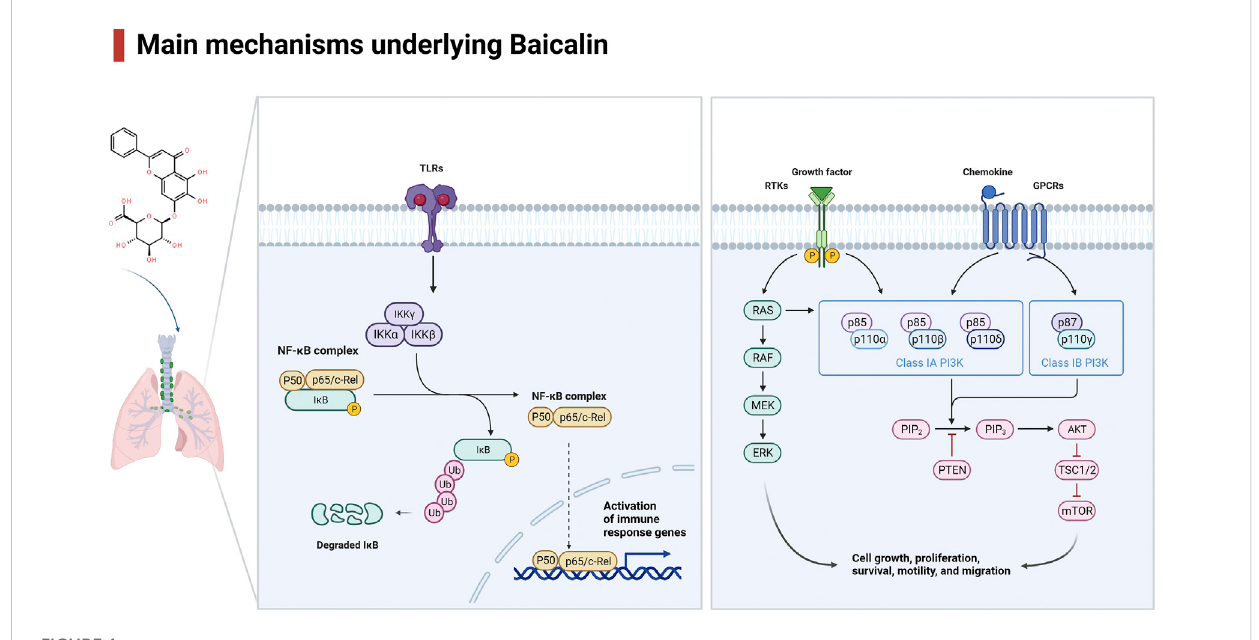
FIGURE 1 Regulatory signaling pathways implicated in